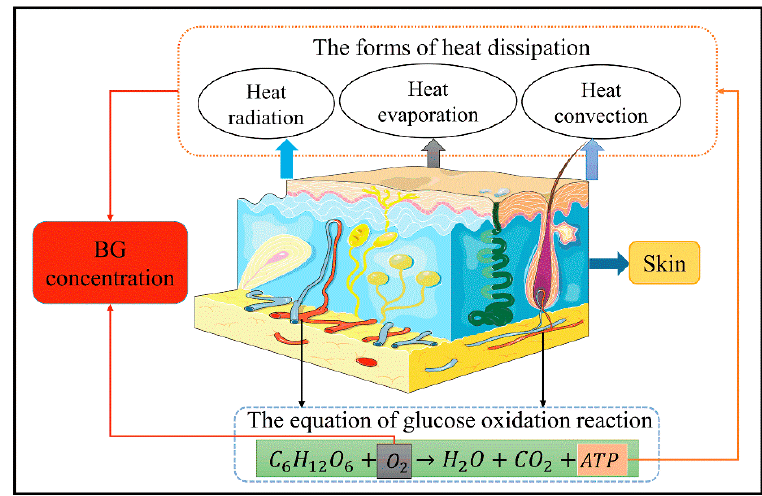
Figure 1. Schematic representation of the human metabolism.